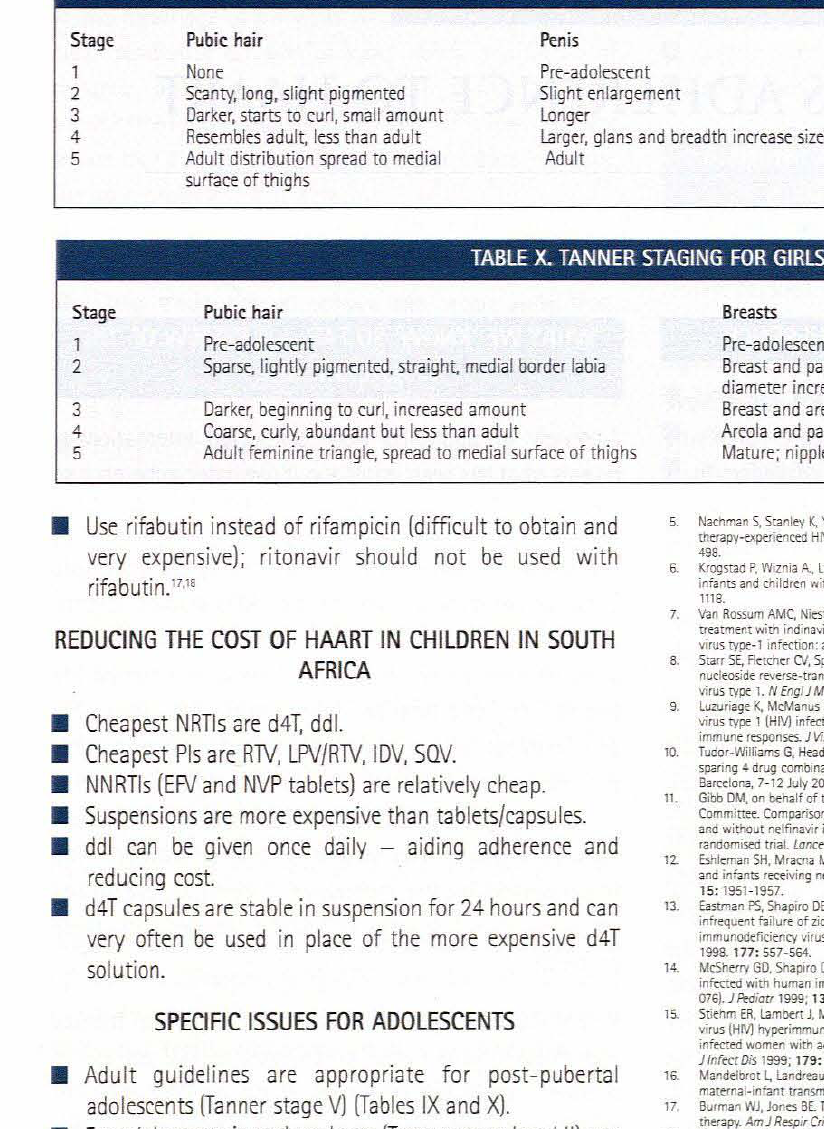
Testes Pre-adolescent Enlarged scrotum, pink texture altered Larger larger, scrotum dark